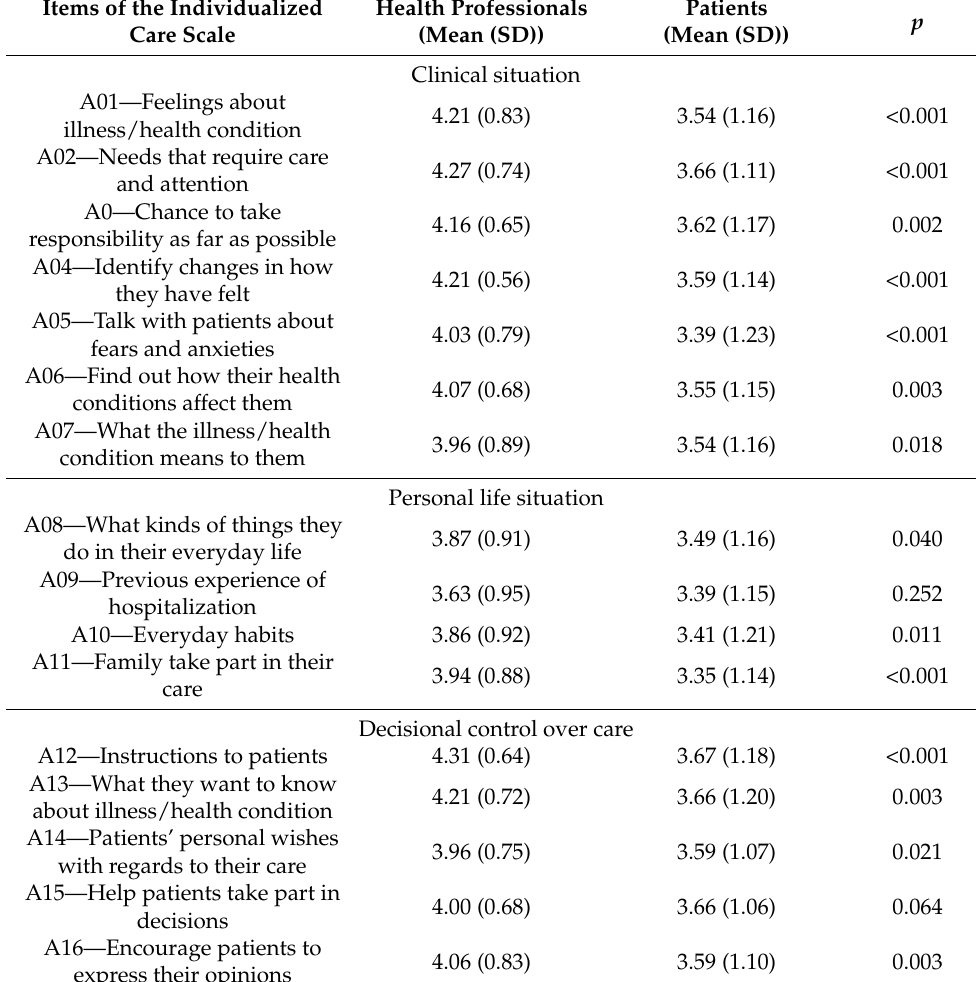
Table 4. Health professionals’ and patients’ assessments of the support of patient individuality: item-level